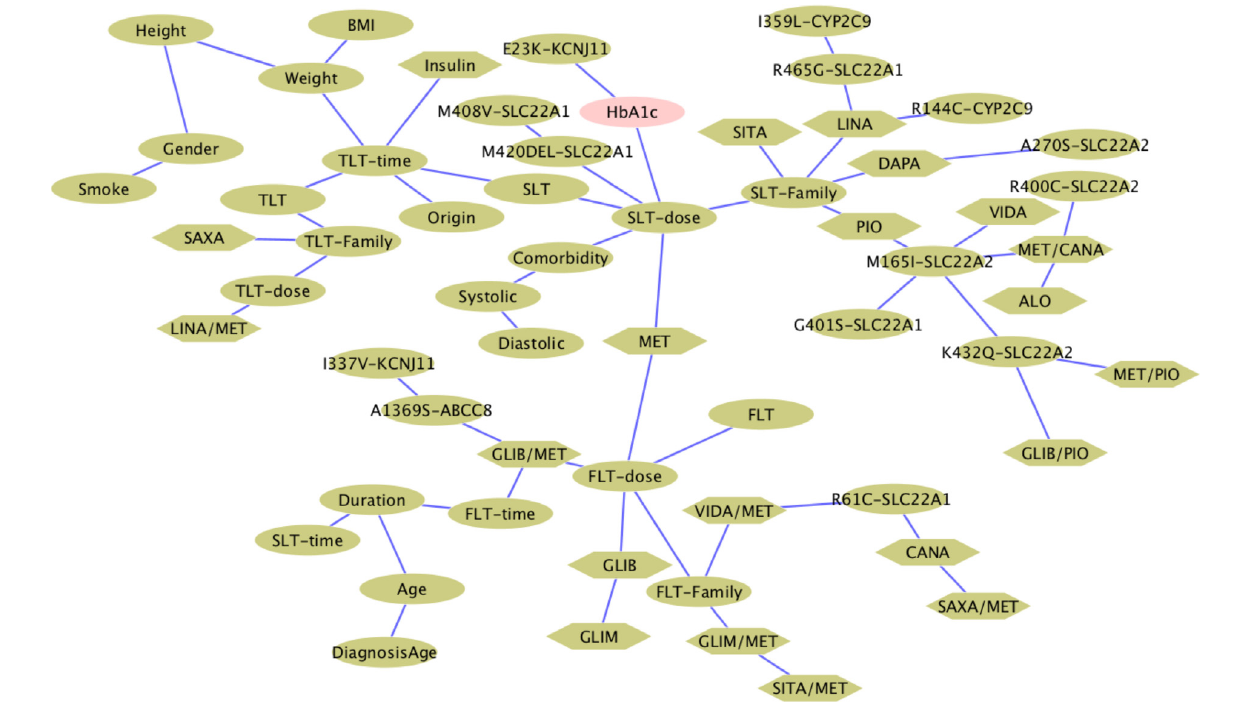
FIGURE 2 | Bayesian network of OADs and factors built from direct information. Hexagonal shapes indicate OADs and ovals denote clinical parameters or